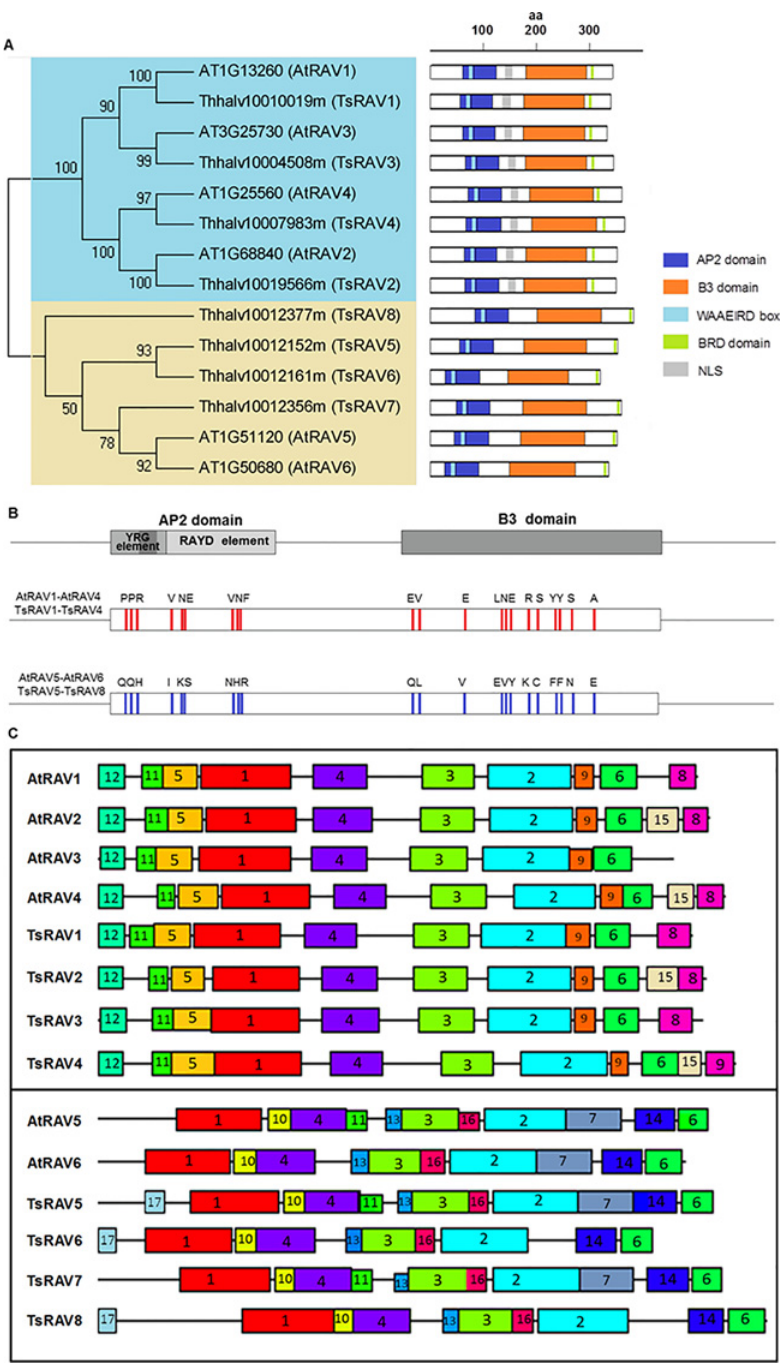
Fig 1. Sequence characterization of RAV family members of Thellungiella salsuginea and Arabidopsis thaliana . (A) Phylogenetic tree of the RAV family members in Thellungiella salsuginea and Arabidopsis thaliana . The phylogenetic tree was constructed using full-length protein sequences by the maximum- likelihood method with MEGA 5.0 and a bootstrap value of 1,000. The two major phylogenetic clades are designated as groups A and B. Shown on the right are diagrams of RAV proteins with information on the structure and position of different protein domains. (B) RAV subfamily-specific amino acids and their locations along the RAV full-length sequences. The amino acid sequences in boxes represent the conserved AP2 and B3 DNA-binding domains, which are characteristic of RAV transcription factors. The locations of the conserved YRG and RAYD elements are indicated as well. (C) Schematic illustrations of the types